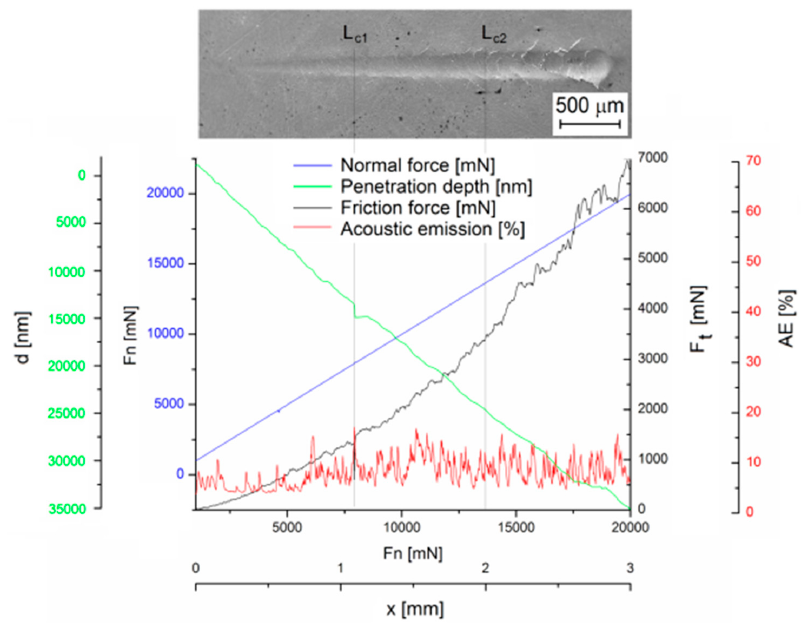
Figure 4. Results of the scratch test for the Ni–P coating on the ZE10 magnesium alloy with a scratch pattern.